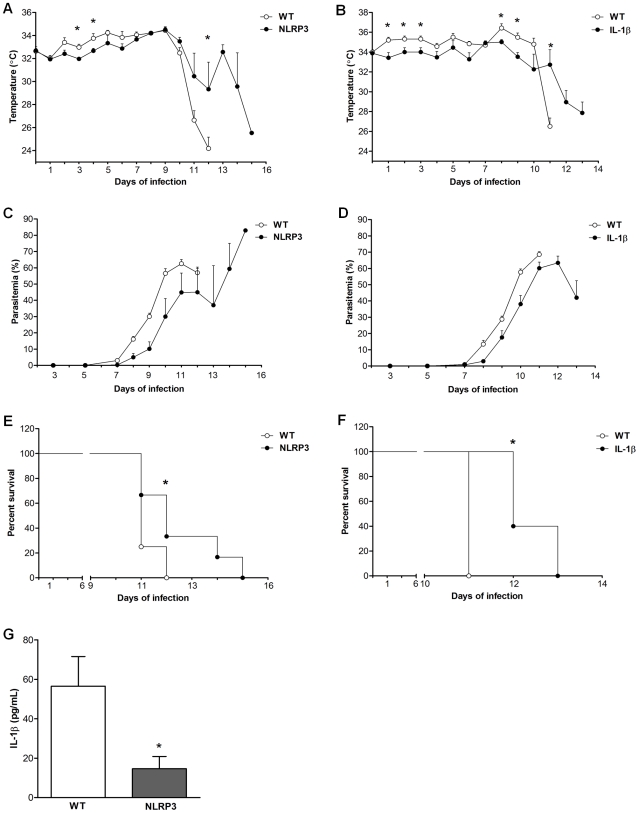
NLPR3- and IL-1β-deficient mice show increased survival to malaria infection and reduced fever.Wild type (WT), NLRP3- or IL-1β-deficient mice were infected with Plasmodium chabaudi adami strain DS and after the indicated time, the mouse body temperature (A and B), parasitemia (C and D), and survival of mice (E and F) were monitored. IL-1β was measured in serum collected before death (G), dashed line represents ELISA detection limit. Statistical differences (A, B and G) were estimated using t test. Statistical significances between survival curves were determined using the Mantel–Haenszel test. *p<0.05. Results from a representative infection experiment (n = 5–8) are shown.